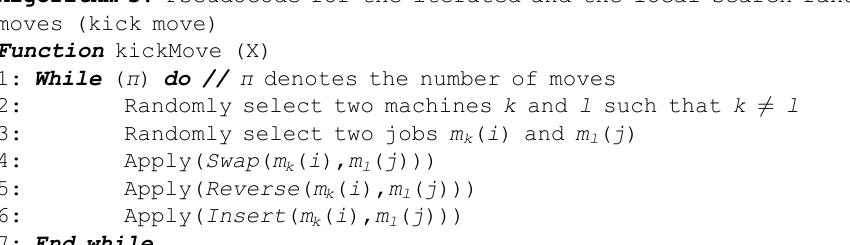
Algorithm 3 : Pseudocode for the iterated and the local search